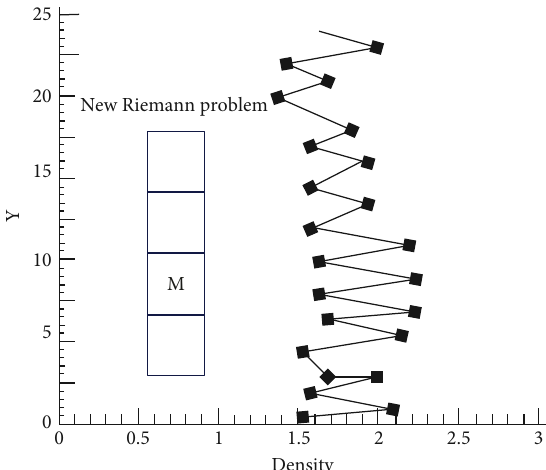
Figure 6: Density distribution along the j-direction inside the shock structure at the initial stage of instability (the results cal- culated by the HLLEM scheme at M